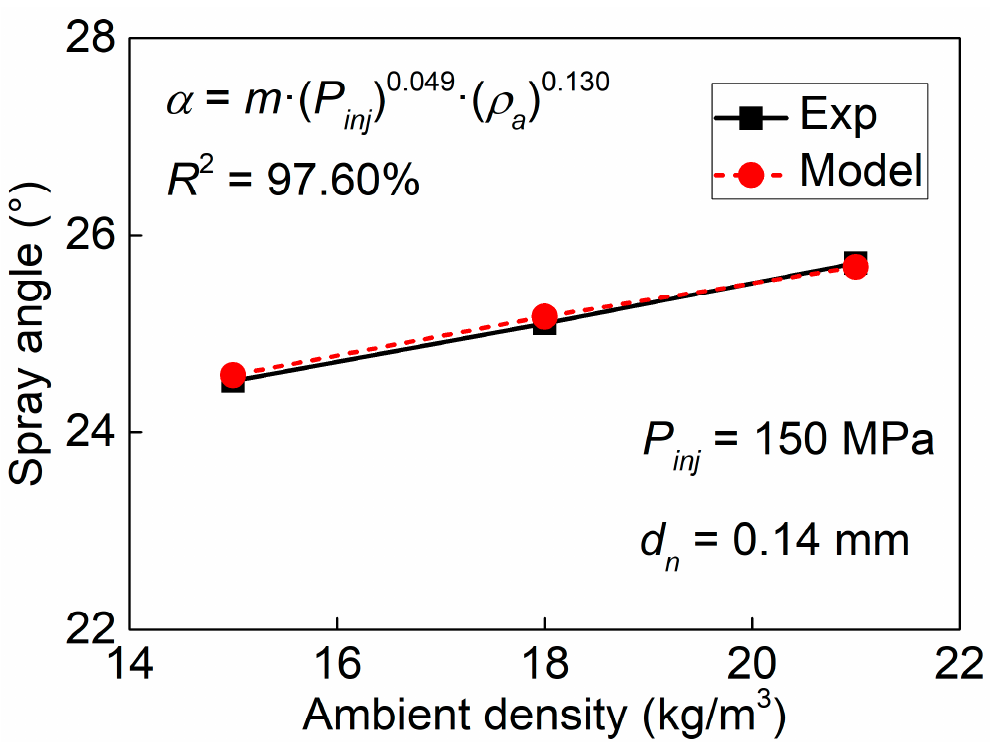
Figure 18. The experimental and predicted results for the spray angle when applying the pilot-main injection strategy under various surrounding gas densities.